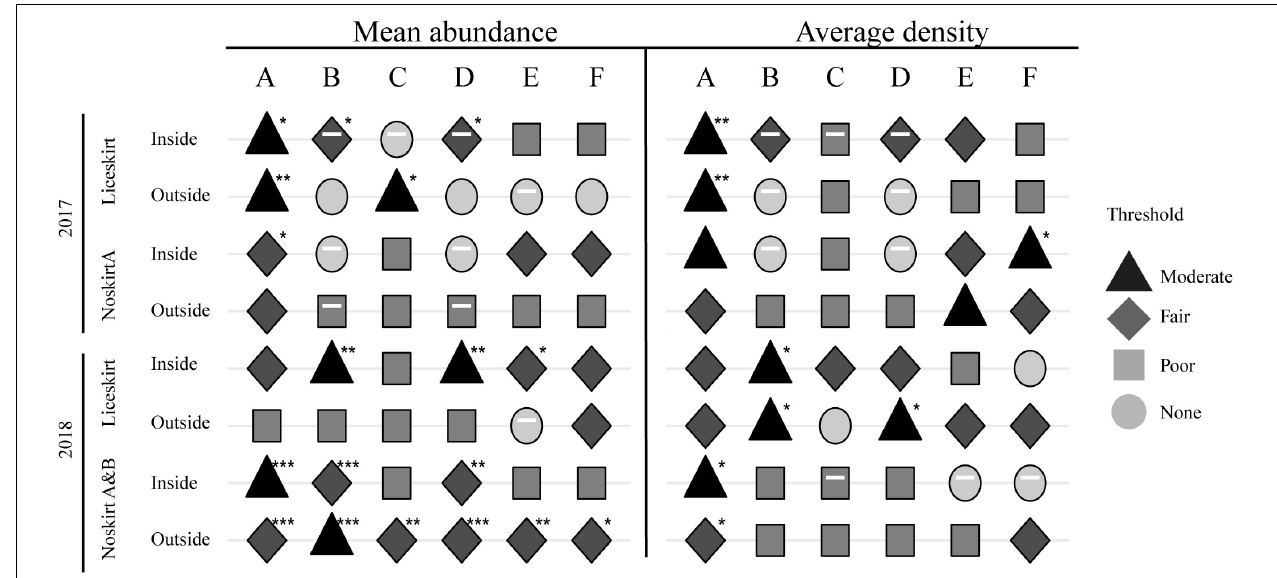
FIGURE 8 | Correlation coefficients (Kendall) between mean abundance or average density of planktonic sea lice (ind. m − 3 ) inside and outside the cage and temperature (A) . Inside and outside refer to where the samples were taken. Temperature-adjusted semi-partial correlation coefficient (Kendall) between mean abundance and average density of planktonic sea lice and lice on the salmon [Adult female L. salmonis (B) and C. elongatus (C) ], and predicted nauplius production of L. salmonis at the level of cage (D) , locality (E) , and management area (F) . Negative correlations are indicated by a white dash inside the shape. Both shape and color indicate the strength of the correlation, thresholds are based on Table 1 . Asterisks indicate p values * < 0.05, ** < 0.01, and *** < 0.001. See Supplementary Table 1 for exact